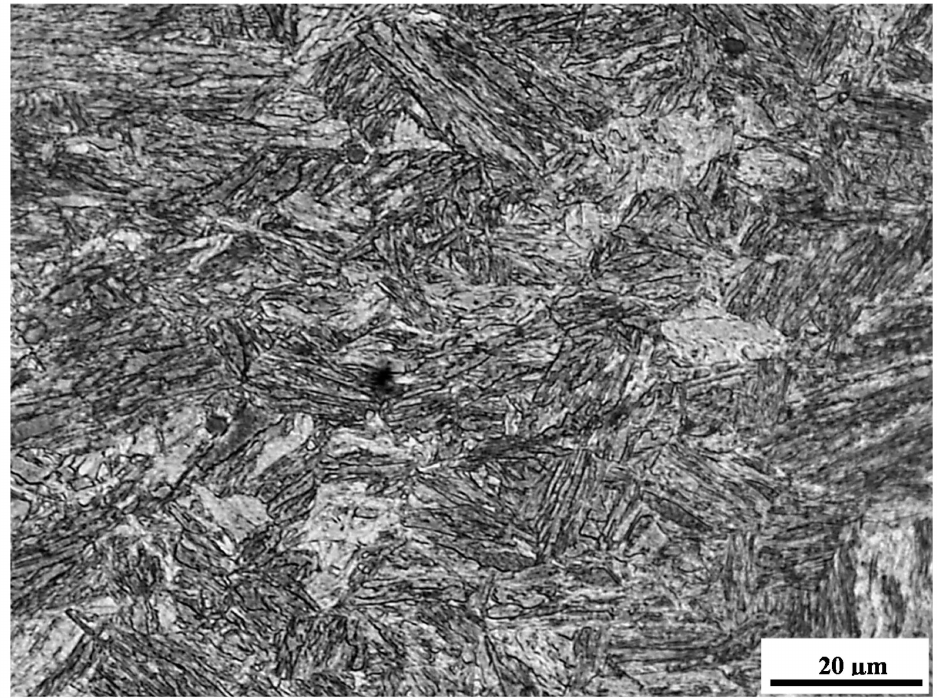
Figure 6. Microstructure of the joint (M90-60-07) after welding with micro-jet cooling. Visible martensite and fine-grained ferrite